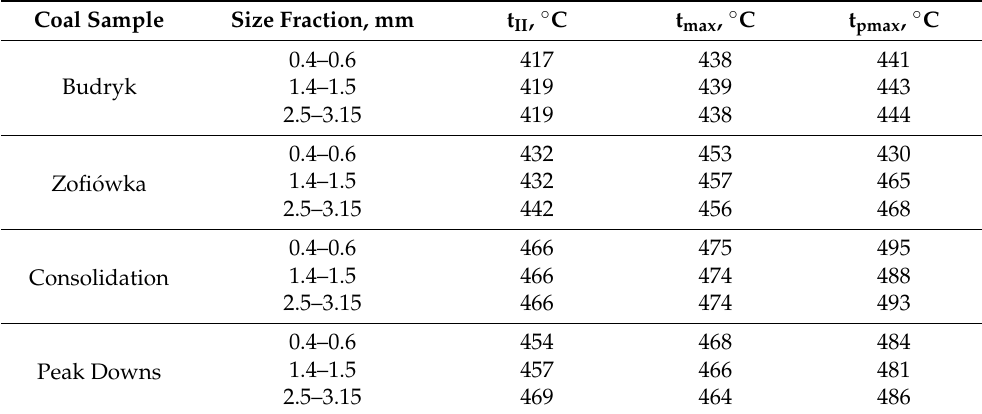
Table 2. Comparison of the temperature of maximal plasticity (and the temperature of dilatation) with the temperature at which the maximal pressure is generated. Coal Sample Size Fraction, mm